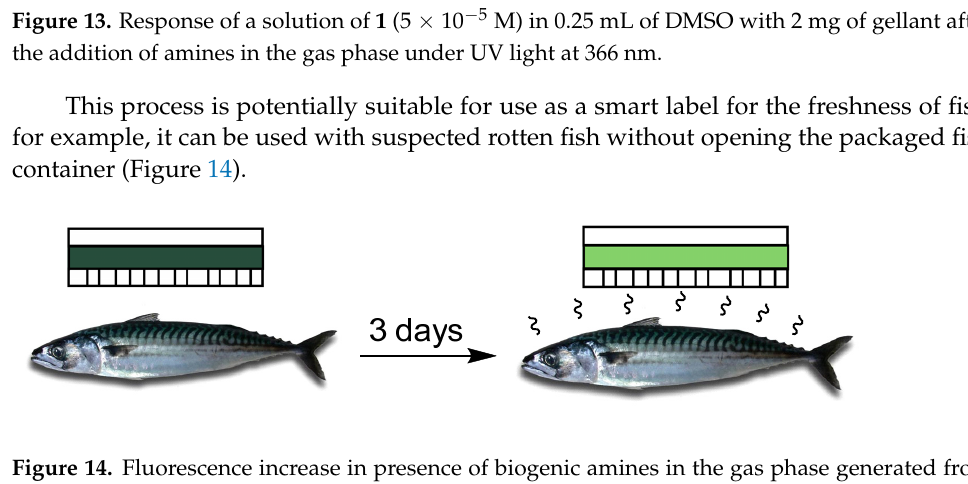
Figure 14. Fluorescence increase in presence of biogenic amines in the gas phase generated from rotten